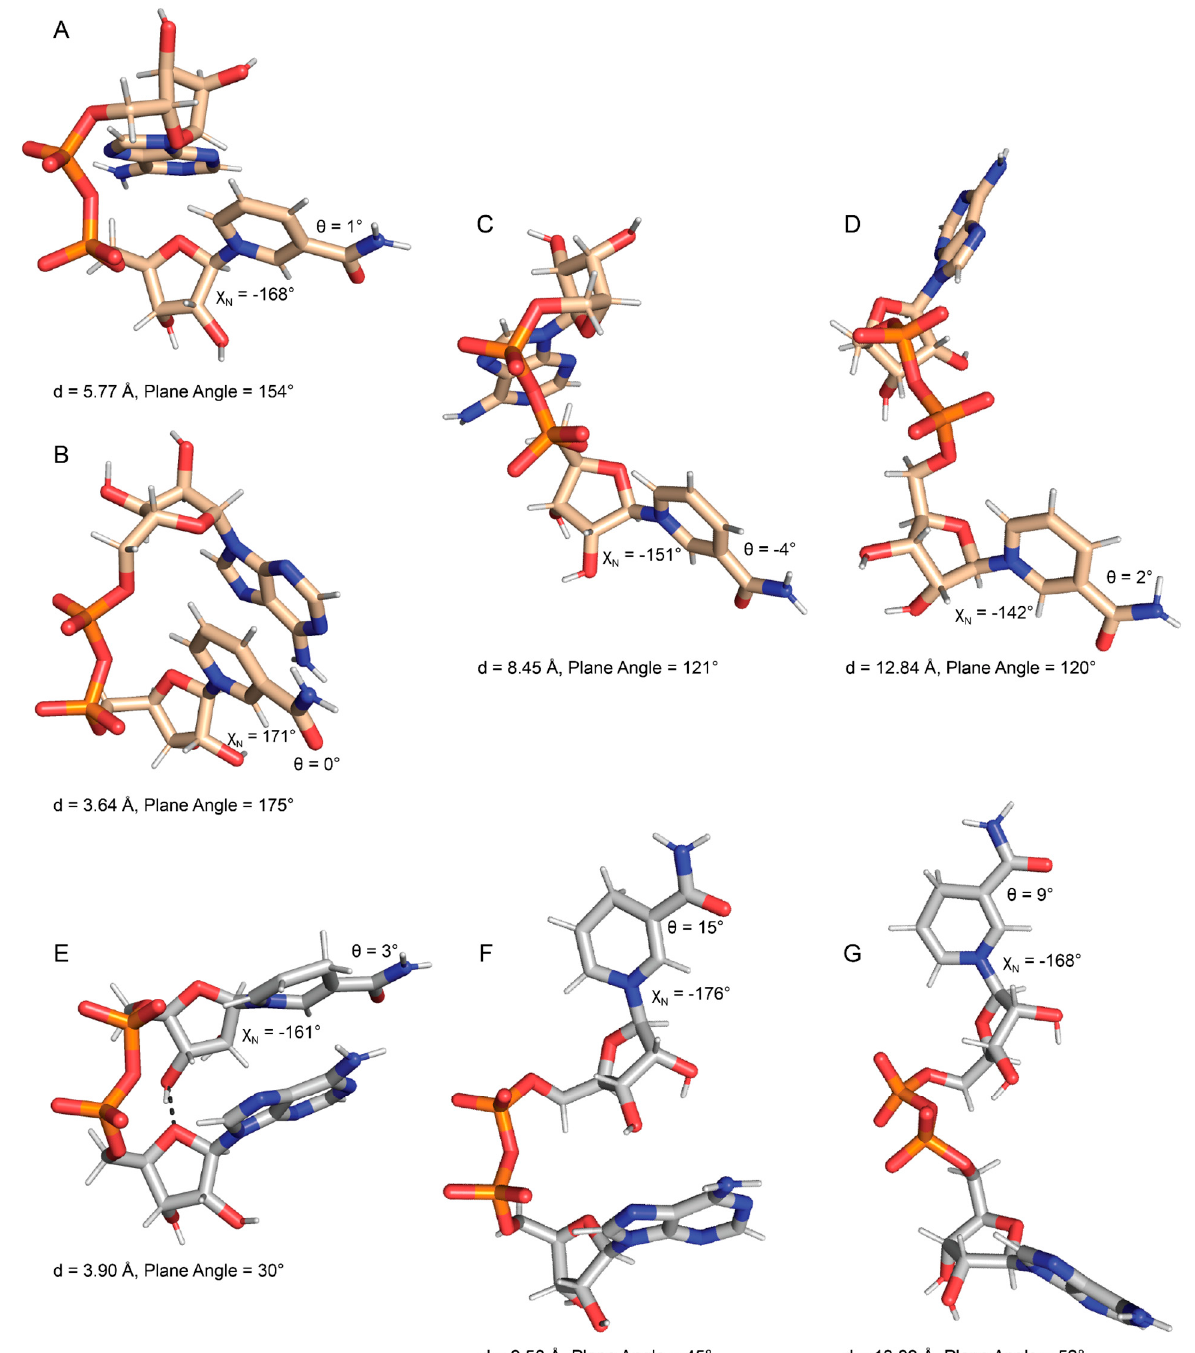
Figure 4. Examples of NAD + (tan) and NADH (gray) conformations. ( A ) The most common folded NAD + . ( B ) The less common folded conformation of NAD + . ( C ) Semi-extended NAD + . ( D ) Extended NAD + . ( E ) Folded NADH. ( F ) Semi-extended NADH. ( G ) Extended conformation of NADH. Values of the inter-base centroid distance “d”, plane angle, θ , and χ N are indicated for each pose. Hydrogen bonds are indicated by dashed black lines between heavy atoms. Cluster representations of these conformations are provided in Supplementary Figure S4.